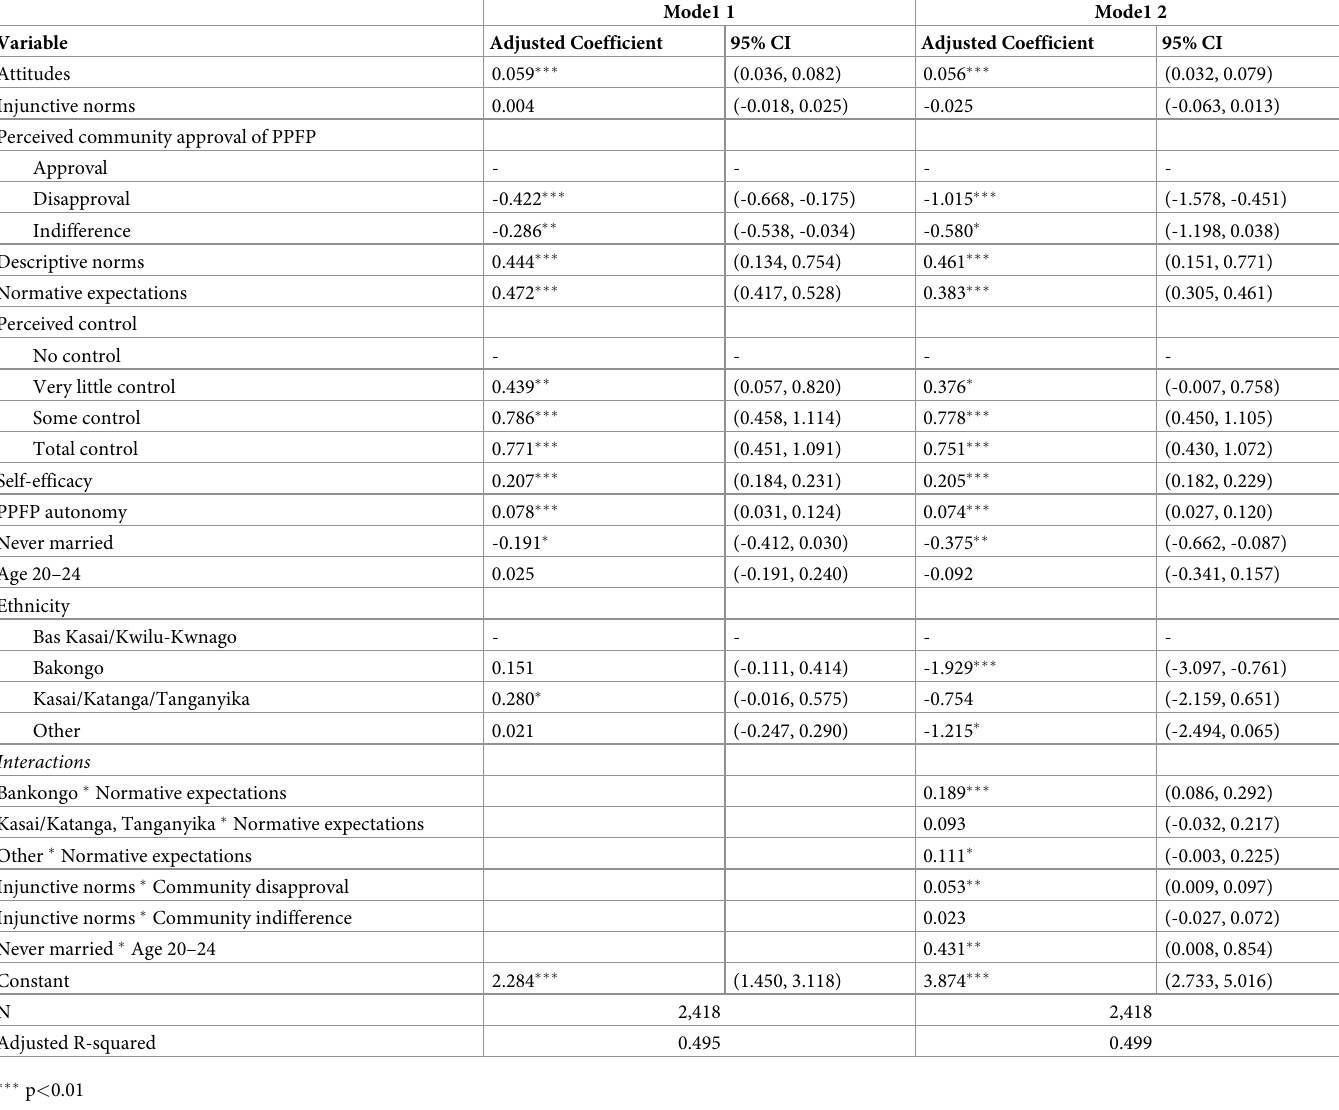
Table 4. Results of multivariable linear regression models of postpartum family planning intentions among first-time mothers age 15–24, Kinshasa